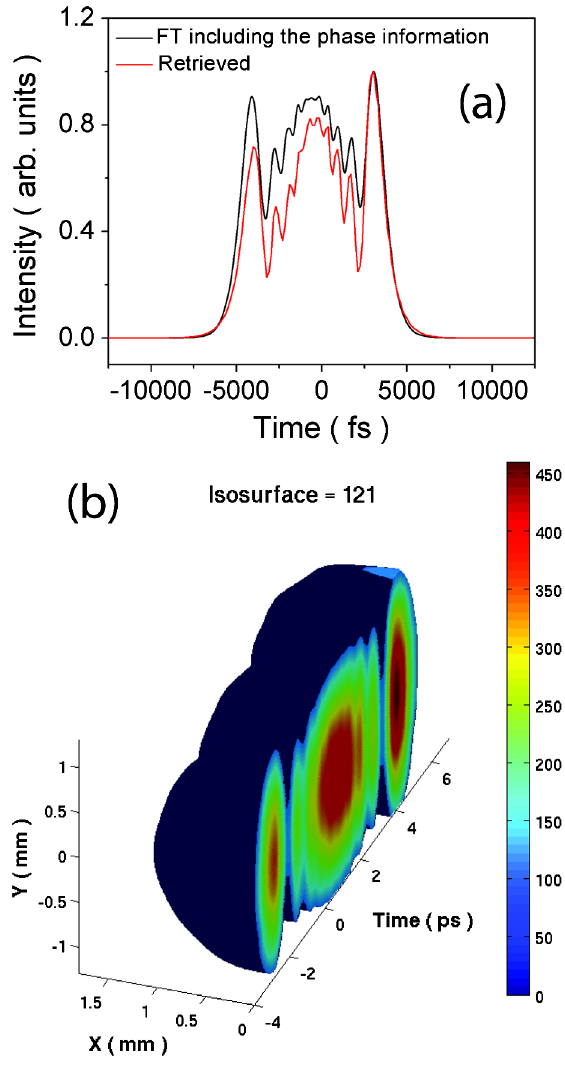
FIG. 9. The ANDi fiber laser results: (a) the temporal intensity distribution; (b) the three-dimensional intensity distribution, plotted in the isointensity